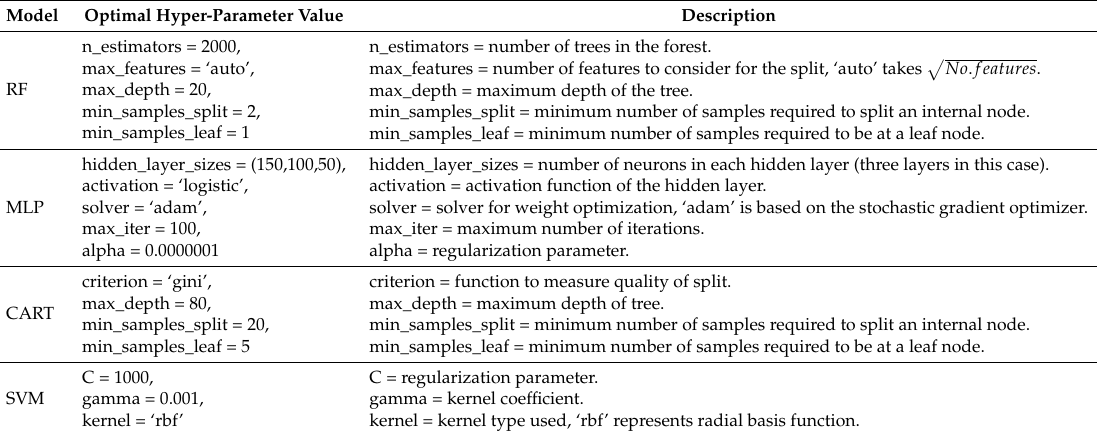
Table A10. Results of optimal hyperparameter values used in each model, from 2 × 5 nested cross-validation using Scikit Learn python package. Refer to the work in [74] for more details on model